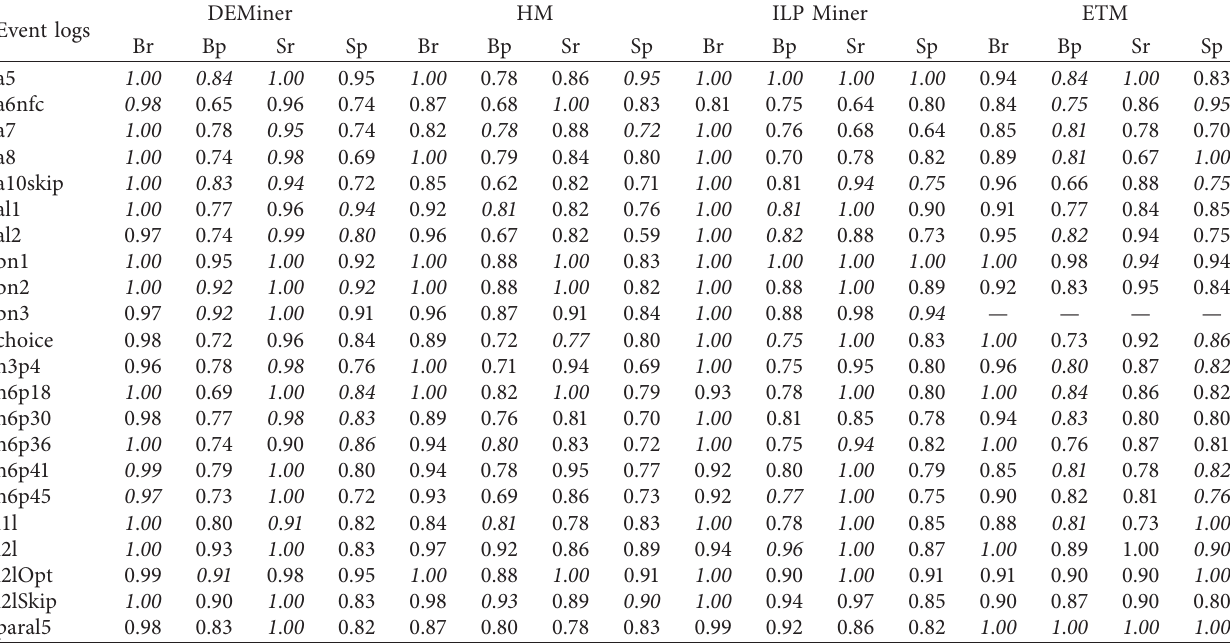
Table 6: Comparison of four algorithms’ performance on 22 event logs with 5% noise. Event